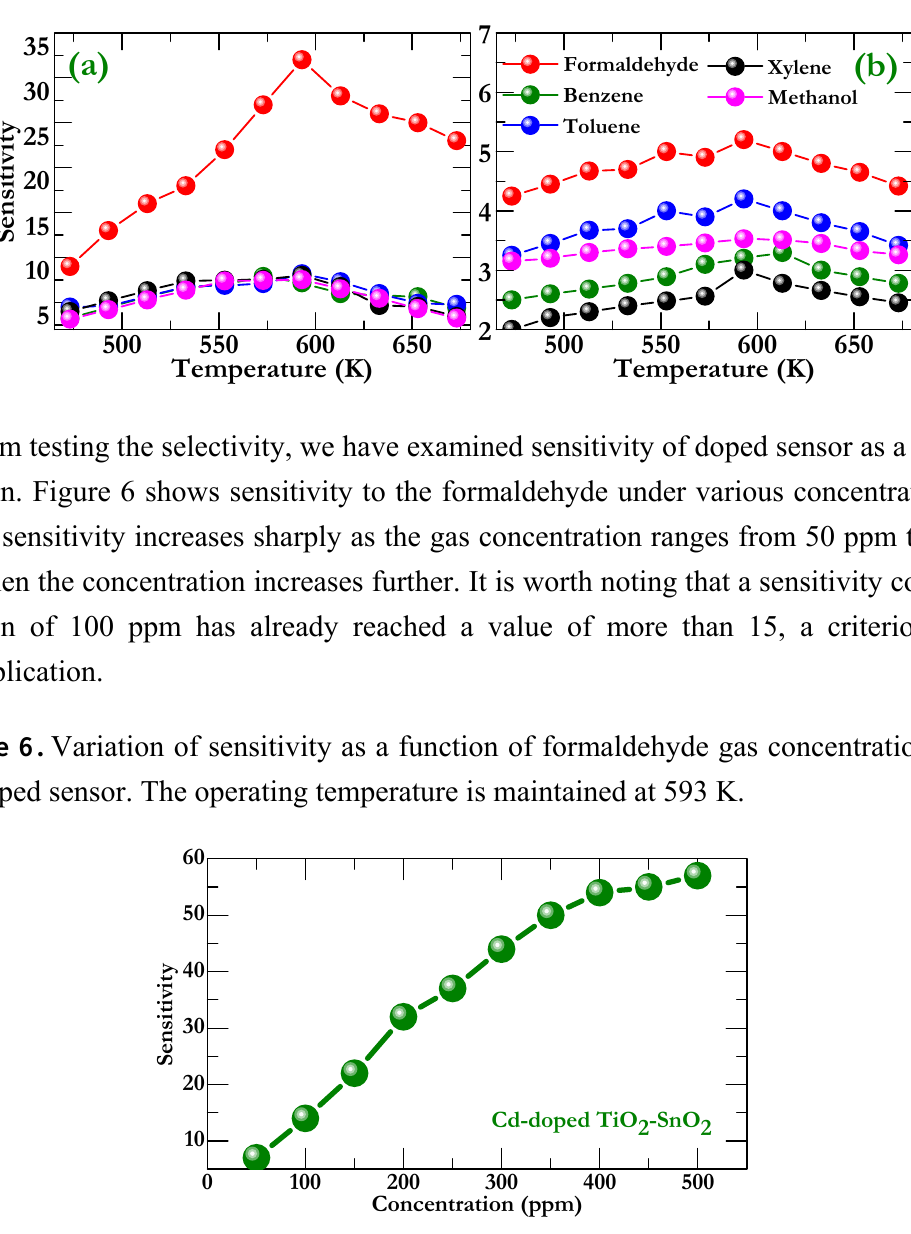
Figure 5. Sensitivity of the sensor fabricated using (a) Cd-doped and (b) pristine TiO -SnO powder under a gas concentration of 200 ppm. Note that the sensitivity scale 2 2 for the doped case is much larger than that for the undoped case.